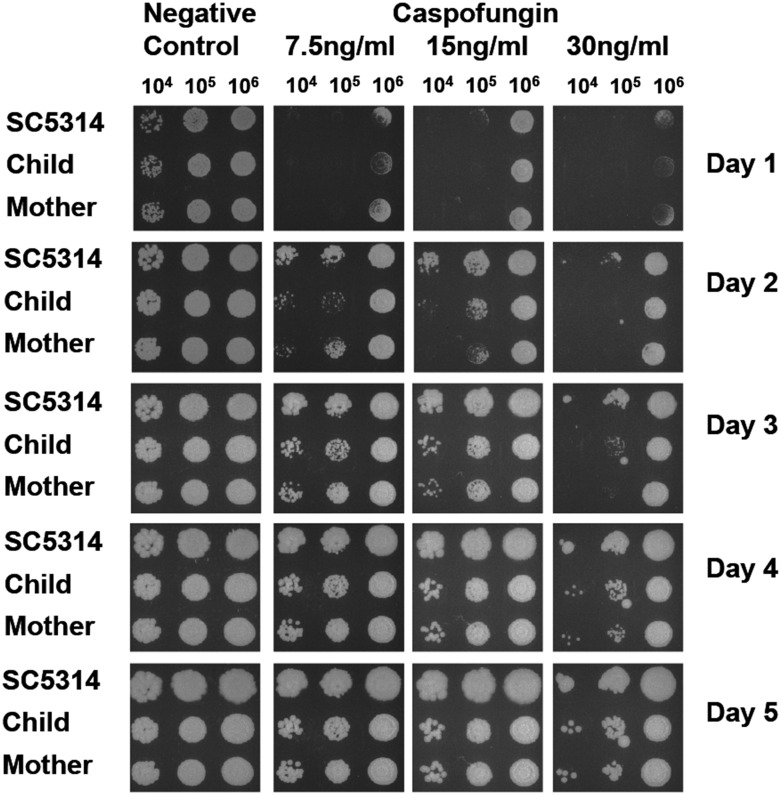
Examples of susceptibility of the clinical isolated C. albicans from S-ECC children and their mothers to antifungal agents casopfungin compared to C. albicans wild strain SC5314.From left to right, 104, 105, and 106 cells were spotted on each plate and incubated at 37°C for up to 5 days. Clinical isolated C. albicans demonstrated less growth and smaller colonies than SC5314 on the YPD medium with caspofungin. However, no significant growth difference was seen between the C. albicans from S-ECC children and their mothers on the YPD medium with caspofungin.